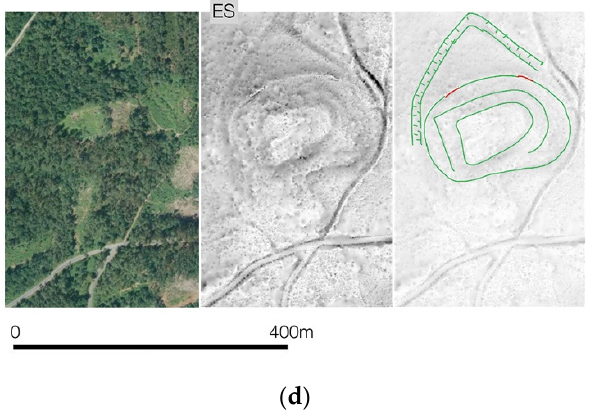
Figure 2. Test data: ( a ) location of test sites: AT—46°53 ′ 05 ″ N, 15°30 ′ 48 ′′ E, SI1—45°40 ′ 21 ″ N, 14°11 ′ 40 ′′ E, SI2—45°40 ′ 56 ″ N, 14°12 ′ 25 ″ E, ES—42°44 ′ 30 ″ N, 8°33 ′ 02 ″ E; ( b ) test site AT; ( c ) test sites SI1 and SI2; ( d ) test site ES. ( b – d ): shown at 100% crop size; left-digital orthophoto; middle-enhanced visualization of manually processed DFM; right-archaeological features (blue: embedded features; green: partially embedded features; red: standing features). DFMs are visualised using sky view factor (RVT 2.2, default settings; after [1], Figure 1; CC-BY 4.0).